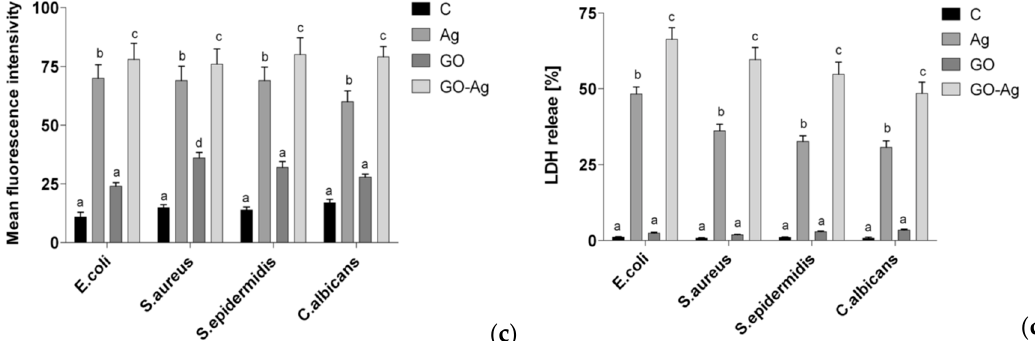
Figure 4. ( a ) Time-kill curves for P. aeruginosa at different concentrations of colloidal GO-AgNPs. The error bars represent the standard deviation of experiments performed in triplicates ( n = 3).